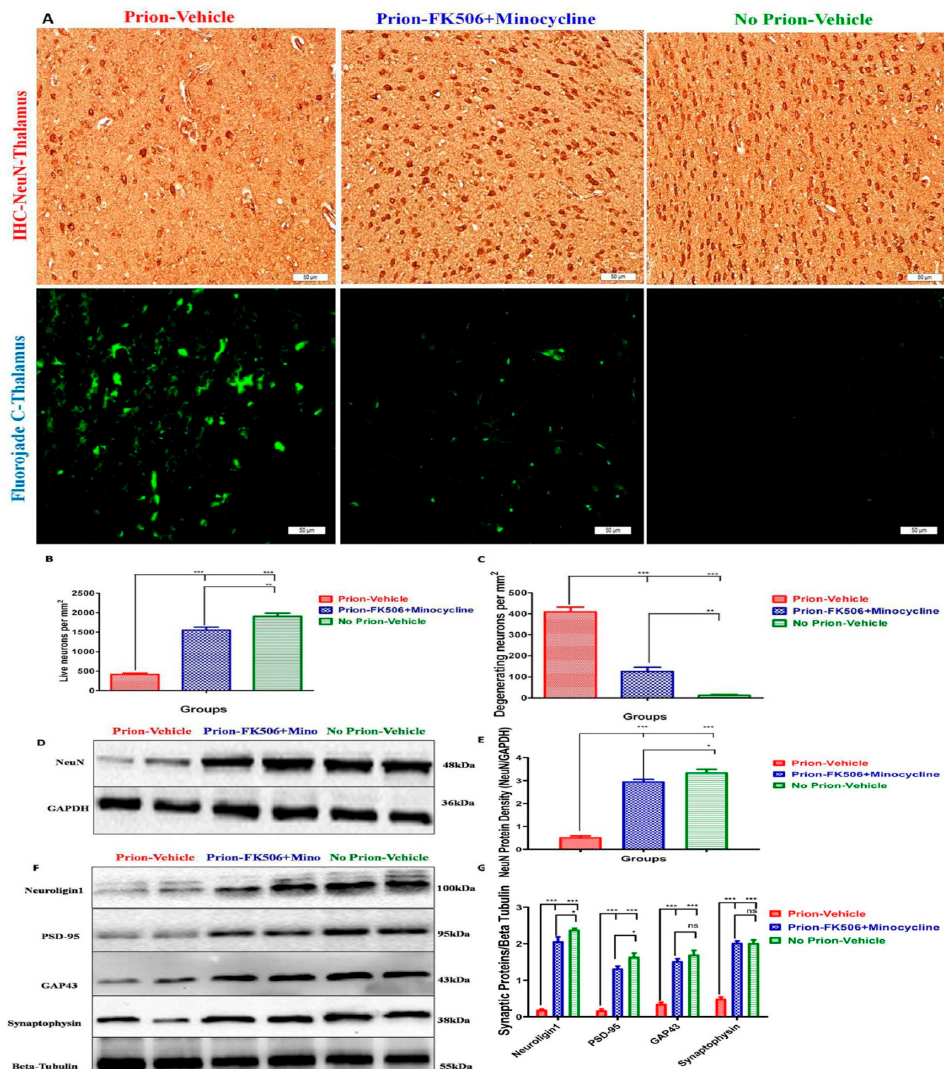
Figure 5. FK506+minocycline treatment rescues prion infected hamsters from synaptic dysfunction and neurodegeneration. ( A ) The top three slides are representative immunohistochemistry pictures of thalamus stained with NeuN antibody to visualize living neurons, while the bottom three slides are representative fluorojade-c stained slides from thalamus for degenerating neurons from prion infected and non infected groups (scale bar-50 μ m). ( B ) Graphical presentation of number of neurons per mm 2 in thalamus of 5 animals per group. The data was analyzed by using one way ANOVA test followed by post hoc test tukey’s multiple comparison. ( P ≤ 0.01 = ** and P < 0.0001 = ***). ( C ) Graphical presentation of the number of degenerating neurons per mm 2 in thalamus of 5 animals per group. The data was analyzed using one way ANOVA test followed by post hoc test tukey’s multiple comparison. ( P ≤ 0.01 = ** and P < 0.0001 = ***). ( D ) Representative western blot panel of two animals each per group for the expression of NeuN in prion infected and non infected animals. ( E ) Graphical presentation of NeuN expression in prion infected and non infected animals. Values were normalized using GAPDH as loading control. Number of animals used for statistical analysis was 5 per group and the The data was analyzed using one way ANOVA test followed by post hoc test tukey’s multiple comparison. ( P ≤ 0.05 = * and P < 0.0001 = ***). ( F ) Representative western blots of two animals each from every group for protein expression of Neuroligin1, PSD-95, GAP43 and synaptophysin. ( G ) Graphical presentation of the expression levels of Neuroligin1, PSD-95, GAP43 and synaptophysin in the brain homogenates of 5 animals each per group. Values were normalized using beta tubulin as loading control. The data was analyzed by using two way ANOVA test followed by bonferroni post hoc test. ( P ≤ 0.05 = *, P < 0.001 = *** and P > 0.05 =